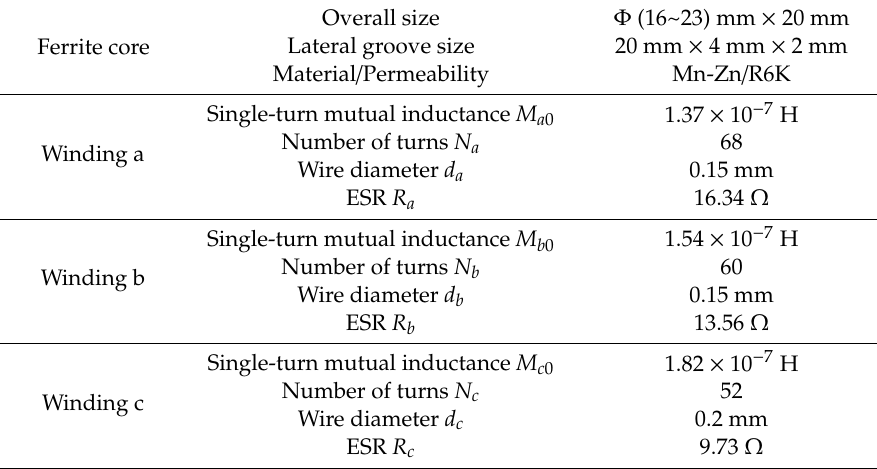
Figure 5. ( a ) Design showing of the hollow-cylinder-like power source, which is composed of a ferrite core, two saddle-shaped windings a and b (arrows indicate winding direction), and a circular winding c; ( b ) a fabricated prototype of the power source for integration. Table 5. Design parameters of the power source.